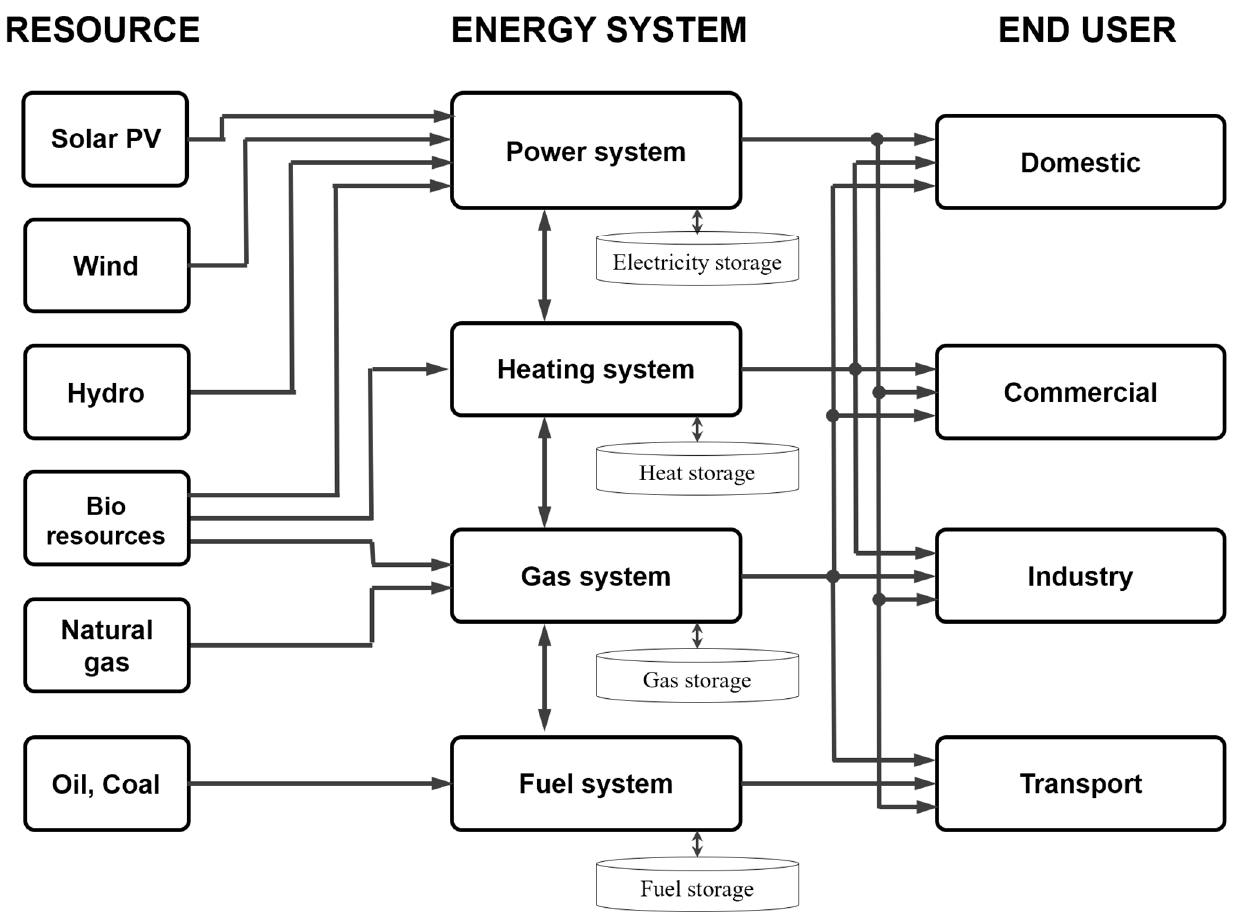
Figure 6. General block diagram of energy during energy transition to interconnect resources, energy system and end users (adapted after [23]).